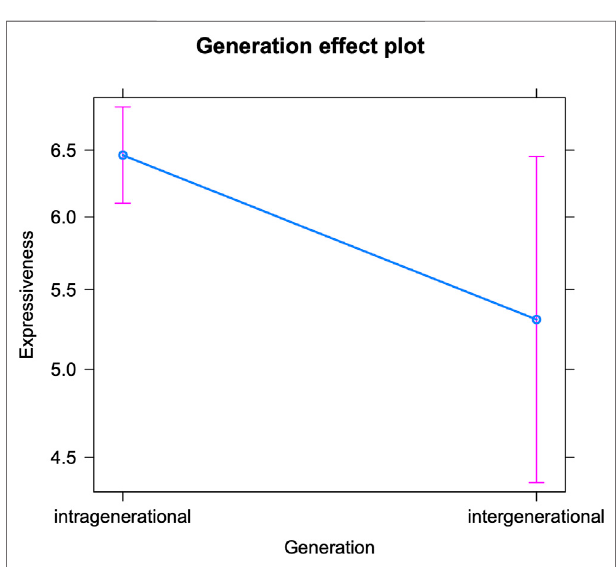
FIGURE 1 | Expressive markers in intra-vs. intergenerational talks (predicted counts per 100